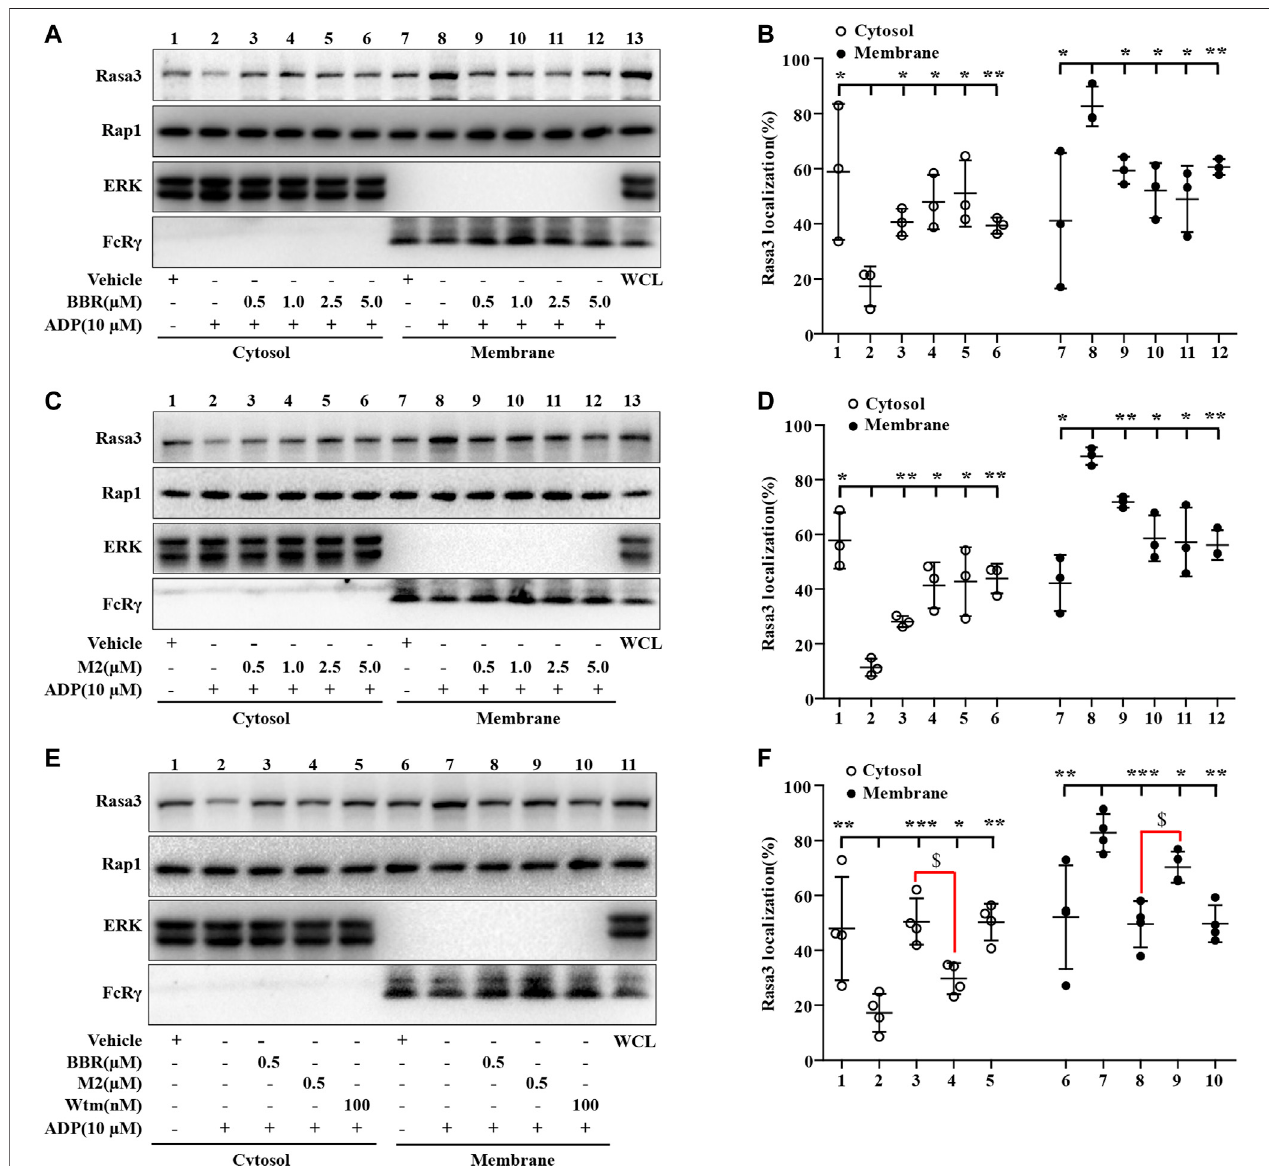
FIGURE5| Effects ofBBRandM2onRasa3membranetranslocation uponADPstimulation invitro .TheWPswerepretreated withthestudied compounds orthe vehiclecontrol(0.1%DMSO)for10min,andstimulatedwith10 μ MofADPfor10 min.Aftertreatment,thecytosolicandmembraneproteinswereextractedforWestern blot to detect Rasa3, Rap1, ERK (cytosolic control protein), and FcR γ (membrane control protein). (A-B) The WPs were pretreated with BBR or the vehicle control as indicated. (C-D) The WPs were pretreated with M2 or the vehicle control as indicated. (E-F) The WPs were pretreated with BBR (0.5 μ M), M2 (0.5 μ M), Wtm (100 nM), or the vehicle control as indicated. Representative blots are presented (A, C, E) . After quanti fi cation, the expression levels of cytosolic and membrane Rasa3 were normalized to those of ERK and FcR γ , respectively, and plotted as indicated (B, D, F) . Data are mean ± SD of three or four independent experiments. Statistically signi fi cant differences compared with ADP group are indicated by * p < 0.05, ** p < 0.01, *** p < 0.001, and statistically signi fi cant differences between the BBR and M2 groups are indicated by $ p < 0.05.